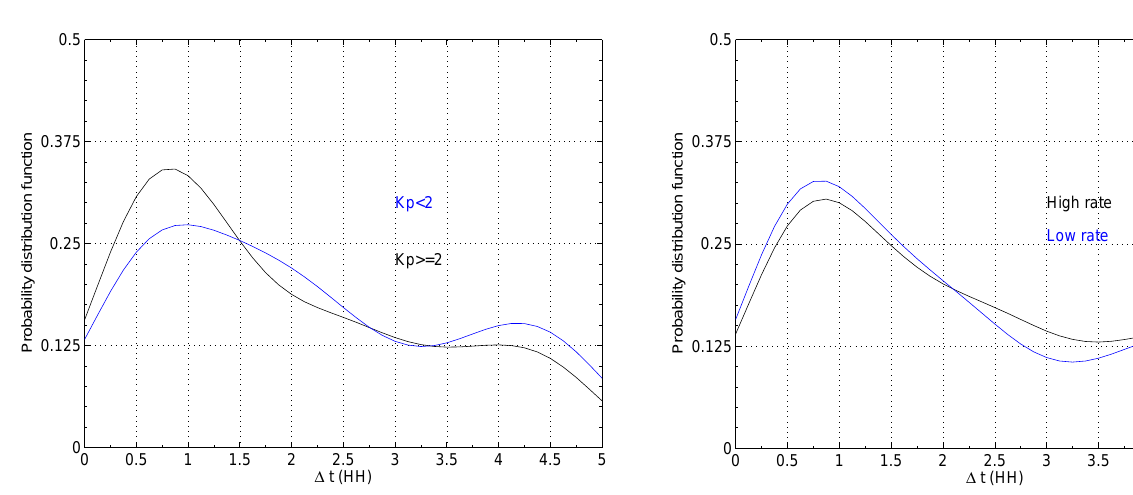
Fig. 9. Same as Fig. 8 except for two groups of “high rate” when solar induced fluxtube integrated conductivity is low (black) and “low rate” when conductance is high